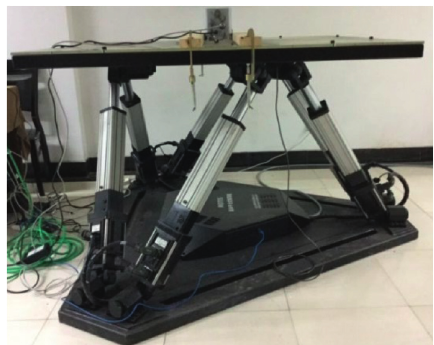
Figure 1: Hexapod motion